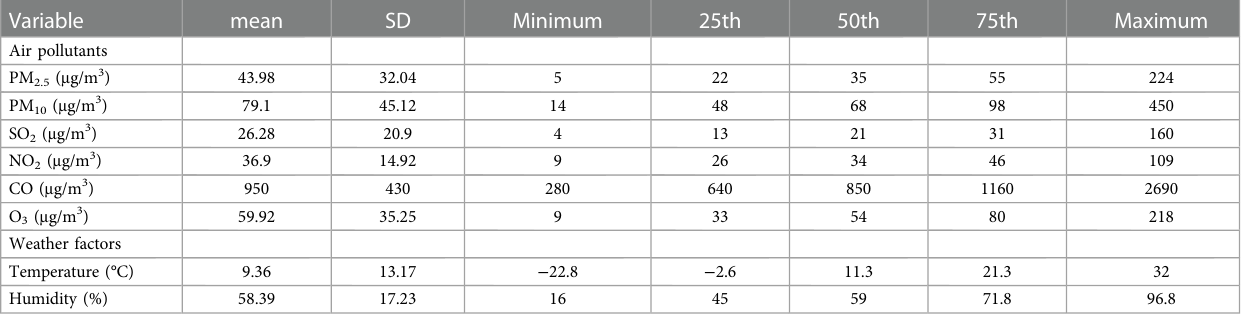
TABLE 2 Descriptive statistics of statistics of daily environment data in Shenyang from 2017 to